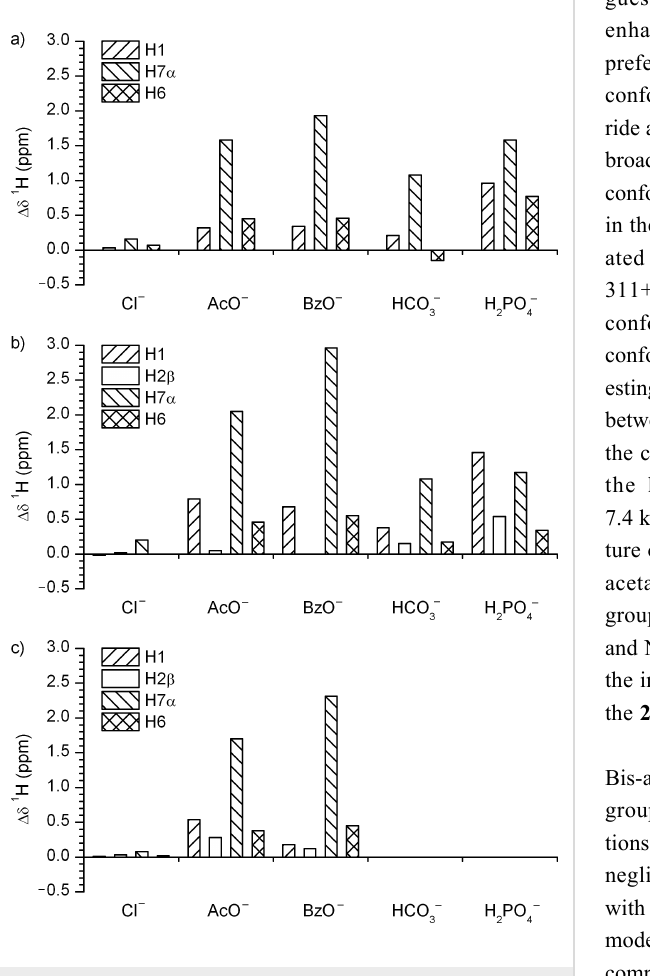
Figure 7: 1 H NMR chemical shift changes, Δδ = δ (in the presence of anions) – δ (in the absence of anions), induced by addition of one equivalent of different anions to receptors 2 (a), 3 (b) and 4 (c). Note, there is no H2 β proton in 2